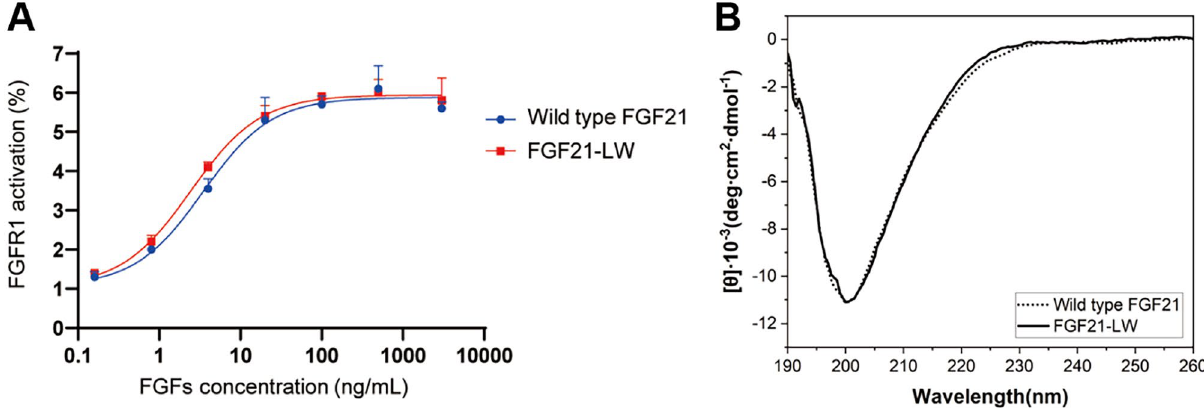
Figure 3. The maintenance of structural and functional properties of the loop-swapped FGF mutant. ( A ) Cell- based activity tests of FGF21-LW. Modified HEK293 cells for reporting FGFR1c activity were treated with the wild type FGF21 or FGF21-LW at the indicated concentration for 6 h. Cell lysates were prepared for detection of luciferase activity. The levels of FGFR1c activity in non-treated cells were set to 1, and the other values were calculated relative to this value (n = 2, average ± SD). ( B ) Comparison of far-UV CD spectra between the wild type FGF21 and